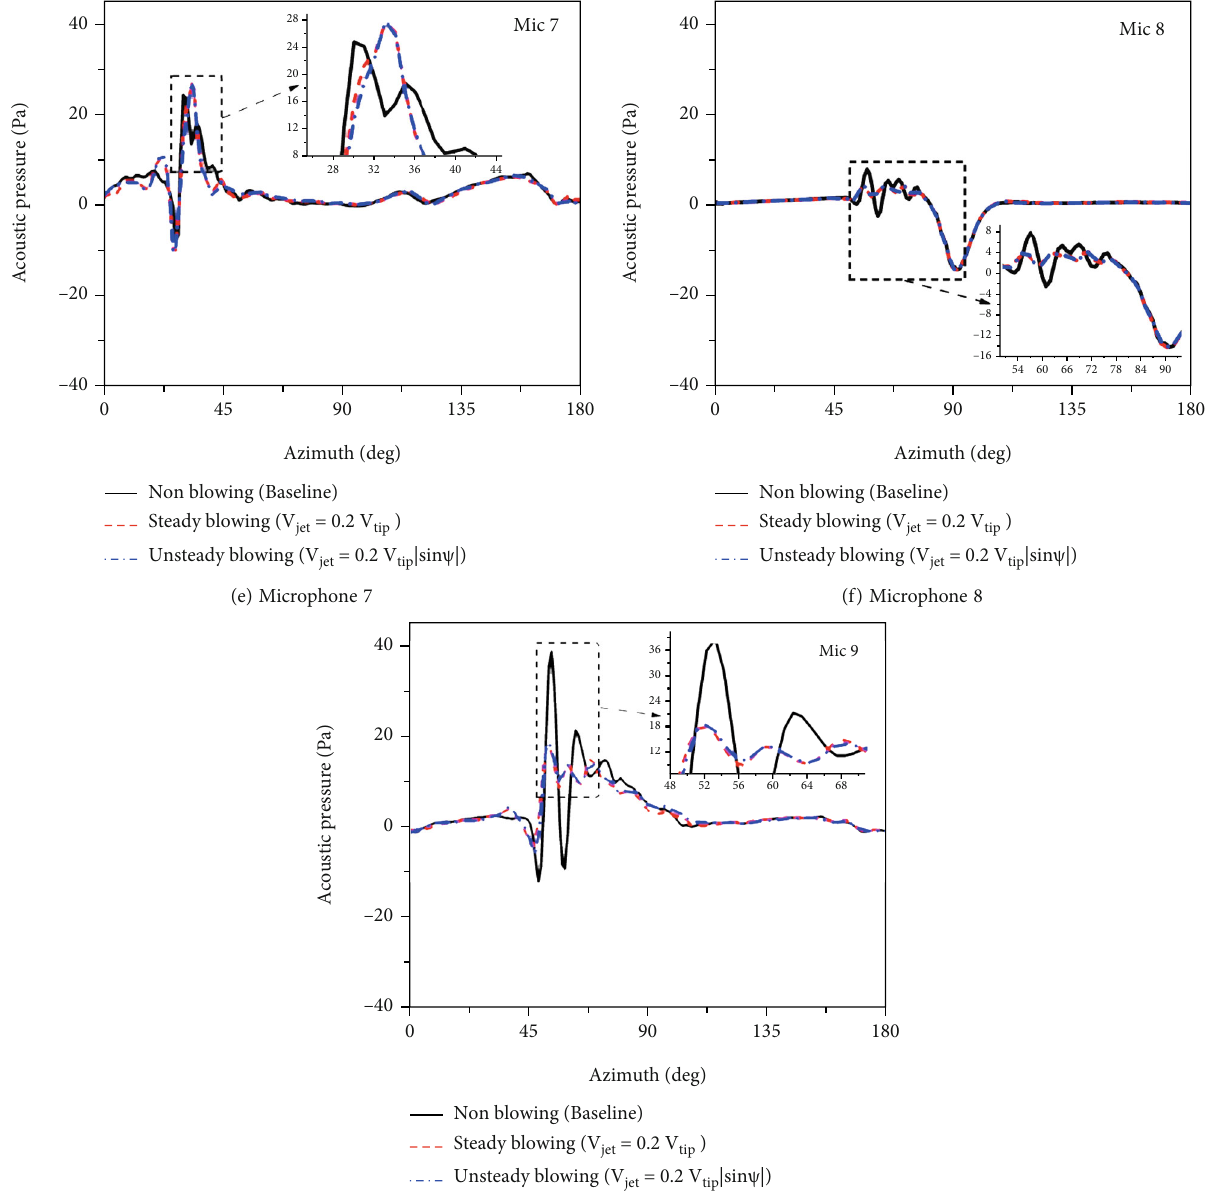
Figure 14: Acoustic pressure time history at all microphones for the steady/unsteady blowing